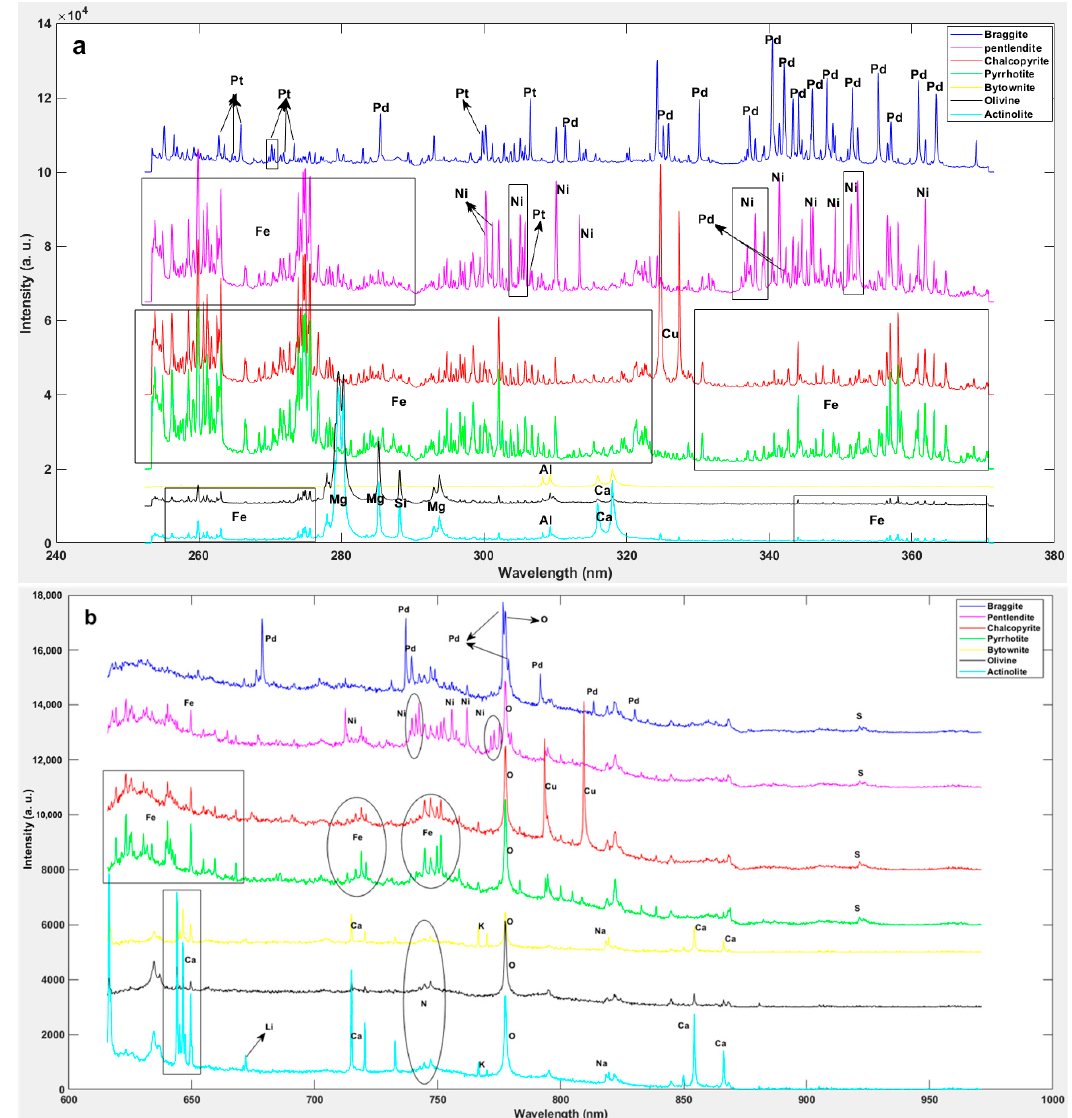
Figure 2. Spectra of the seven mineral spectral fingerprints identified on the scanned area. ( a ) Spectra from 240 to 380 nm. ( b ) Spectra from 600 to 970 nm.